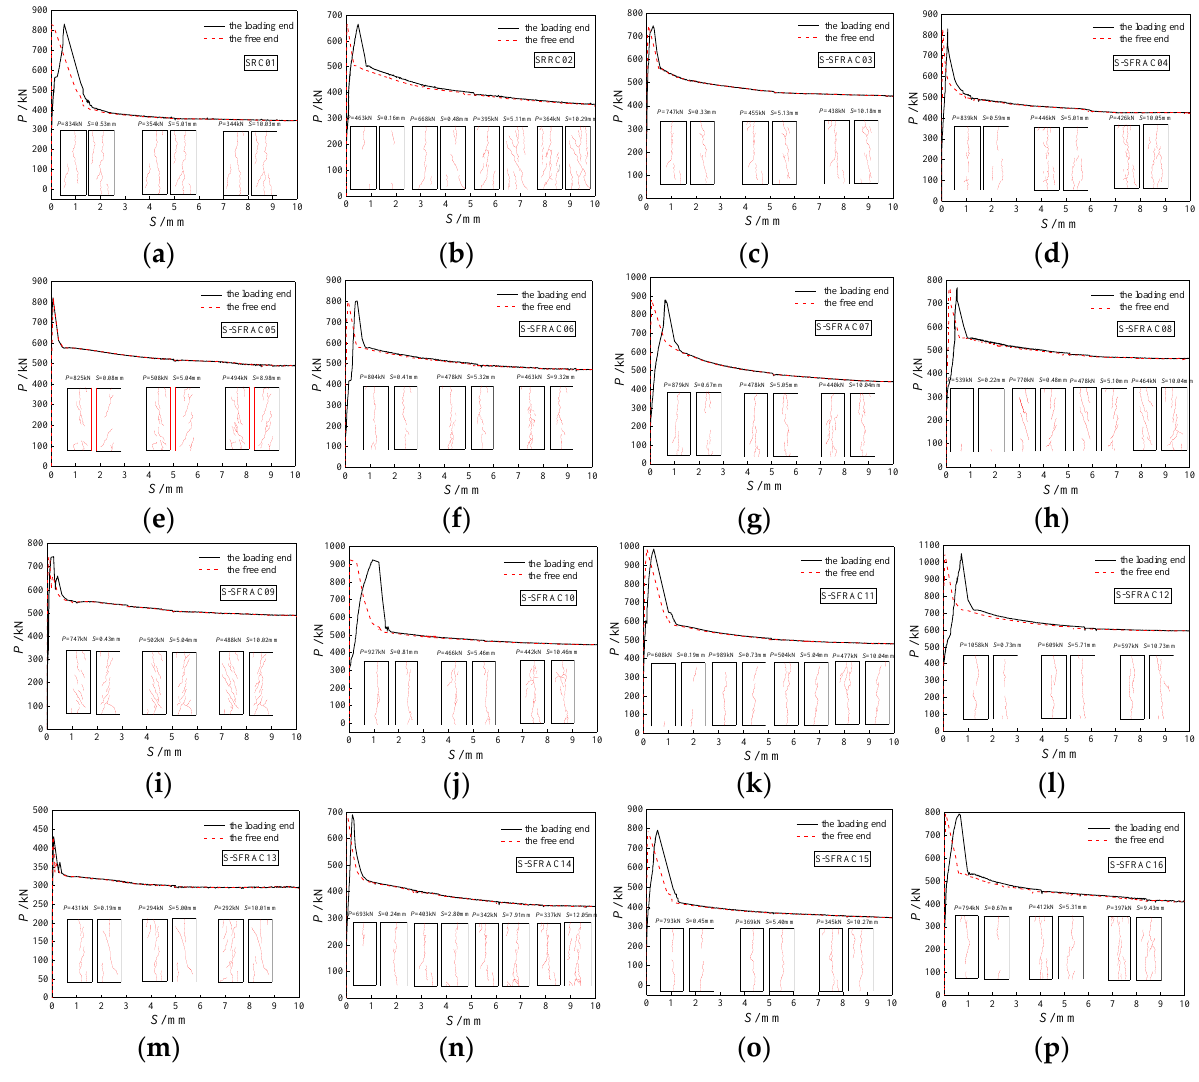
Figure 13. P – S curves of the test specimens. ( a ) SRC01. ( b ) SRC02 . ( c ) S-SFRAC03. ( d ) S-SFRAC04. ( e ) S-SFRAC05. ( f ) S-SFRAC06. ( g ) S-SFRAC07. ( h ) S-SFRAC08. ( i ) S-SFRAC09. ( j ) S-SFRAC10. ( k ) S-SFRAC11. ( l ) S-SFRAC12. ( m ) S-SFRAC13. ( n ) S-SFRAC14. ( o ) S-SFRAC15. ( p ) S-SFRAC16.